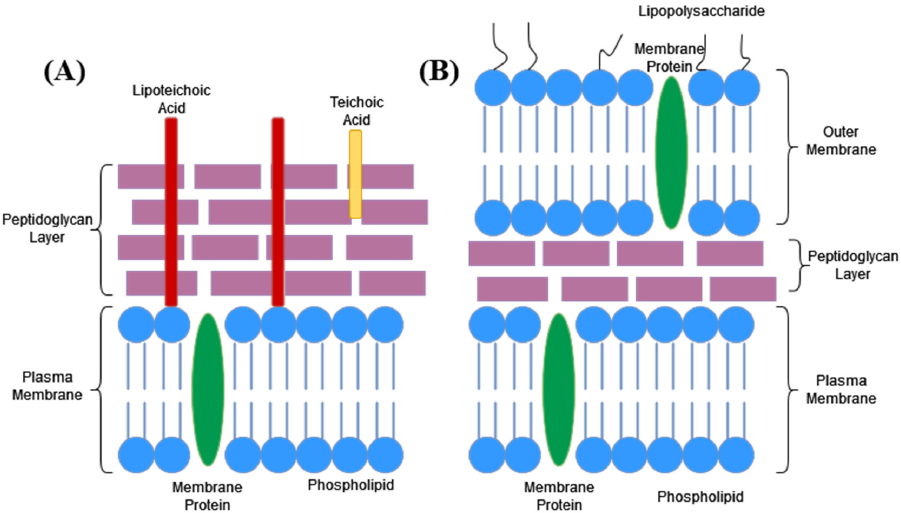
Figure 7. Bacterial cell wall structure. ( A ) Gram-positive bacteria. ( B ) Gram-negative bacteria.